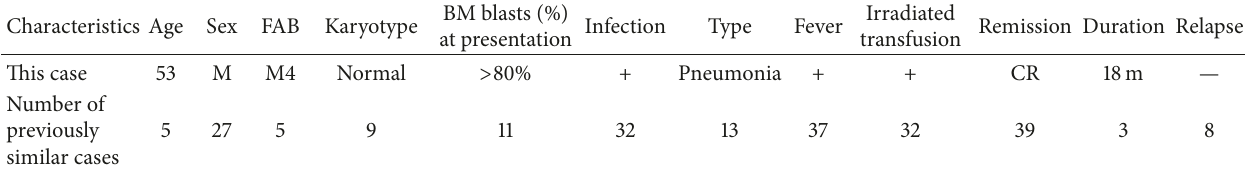
Table 1: Compare the characteristics of this case with previous similar cases reported by Rashidi and